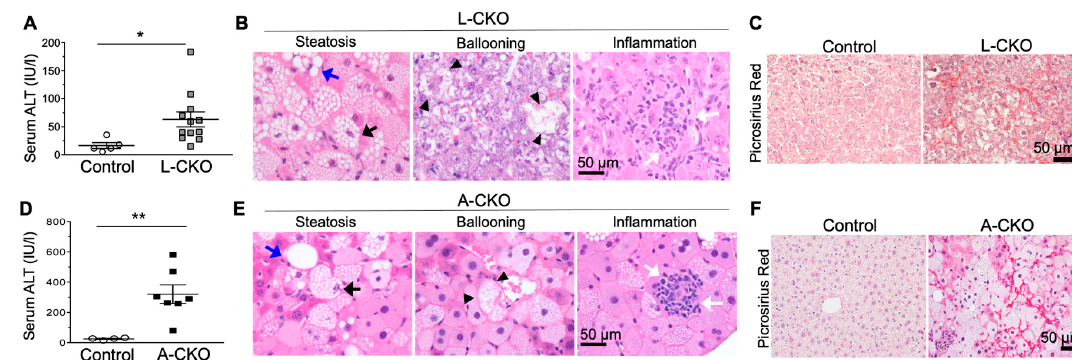
Figure 3. Nonalcoholic steatohepatitis (NASH) features and fibrosis in chow-fed L-CKO mice and A-CKO mice. ( A ) Serum alanine aminotransferase (ALT) activity in L-CKO mice at 12–18 months of age ( n = 5–12 mice per group). * p < 0.05, by Student’s t test. ( B ) Representative photomicrographs of H&E-stained liver sections from L-CKO mice at 18 months of age; scale bar: 50 µ m. Examples of steatosis, hepatocyte ballooning, and inflammation are shown. Macrovesicular steatosis is indicated by blue arrows and microvesicular steatosis is indicated by black arrows. Arrowheads indicate hepatocytes with ballooning degeneration. White arrows indicate inflammatory cells. ( C ) Picrosirius Red-stained liver sections showing increased fibrosis in L-CKO mice at 18 months of age. ( D ) Serum ALT activity in A-CKO mice at 6 months of age ( n = 4–7 mice per group). ** p < 0.01, by Student’s t test. ( E ) Representative H&E-stained sections of livers from A-CKO mice at 6 months of age. Examples of steatosis, hepatocyte ballooning, and inflammation are shown; Macrovesicular steatosis is indicated by blue arrows and microvesicular steatosis indicated by black arrows. Arrow heads indicate hepatocytes with ballooning degeneration. White arrows indicate inflammatory cells. ( F ) Picrosirius Red-stained liver sections showing increased fibrosis in A-CKO mice at 6 months of age. (Reproduced with permission from Shin et al., 2019 [24]).